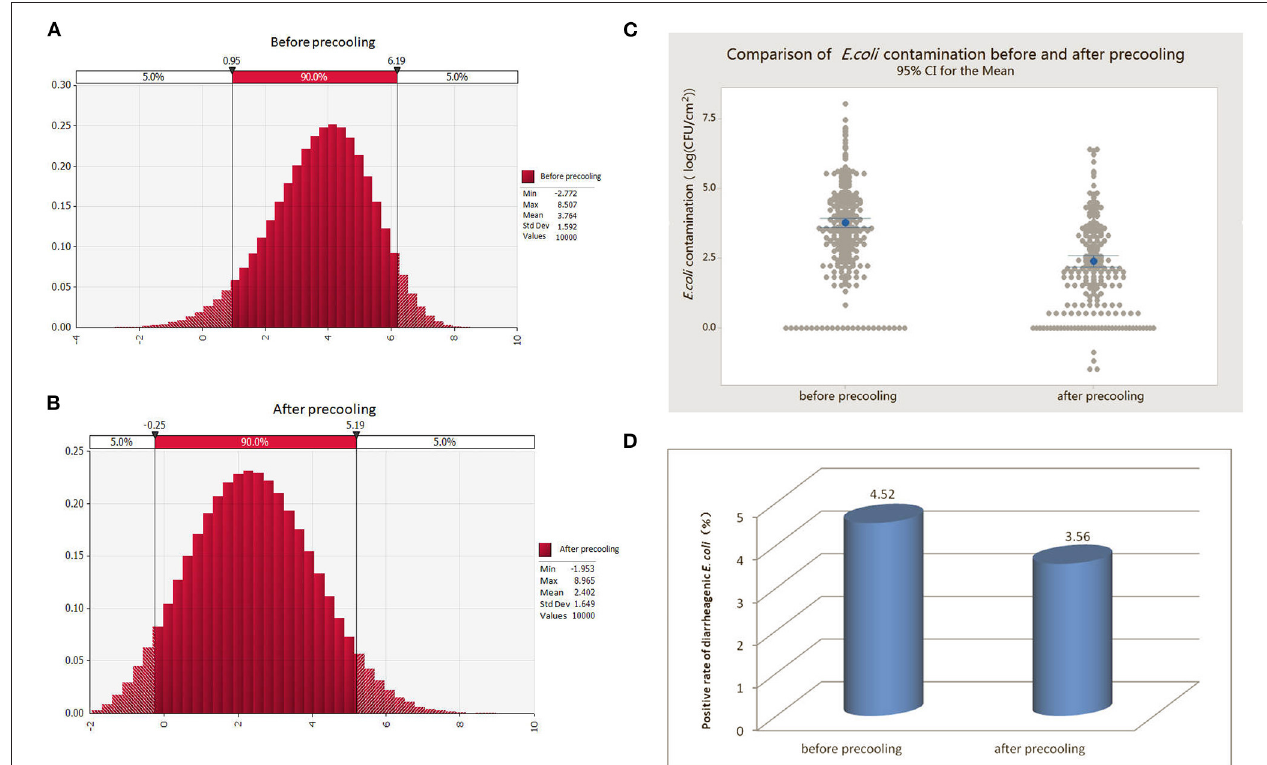
FIGURE 2 | Comparison of the amount of E. coli and diarrheagenic E. coli contamination in pre-cooled and non-pre-cooled pork. (A) Probability distribution of E. coli contamination in pork before pre-cooling. (B) Probability distribution of E. coli contamination in pork after pre-cooling. (C) Comparison of E. coli contamination in pork before and after pre-cooling. (D) Exposure status of diarrheagenic E. coli contamination in pork before and after pre-cooling